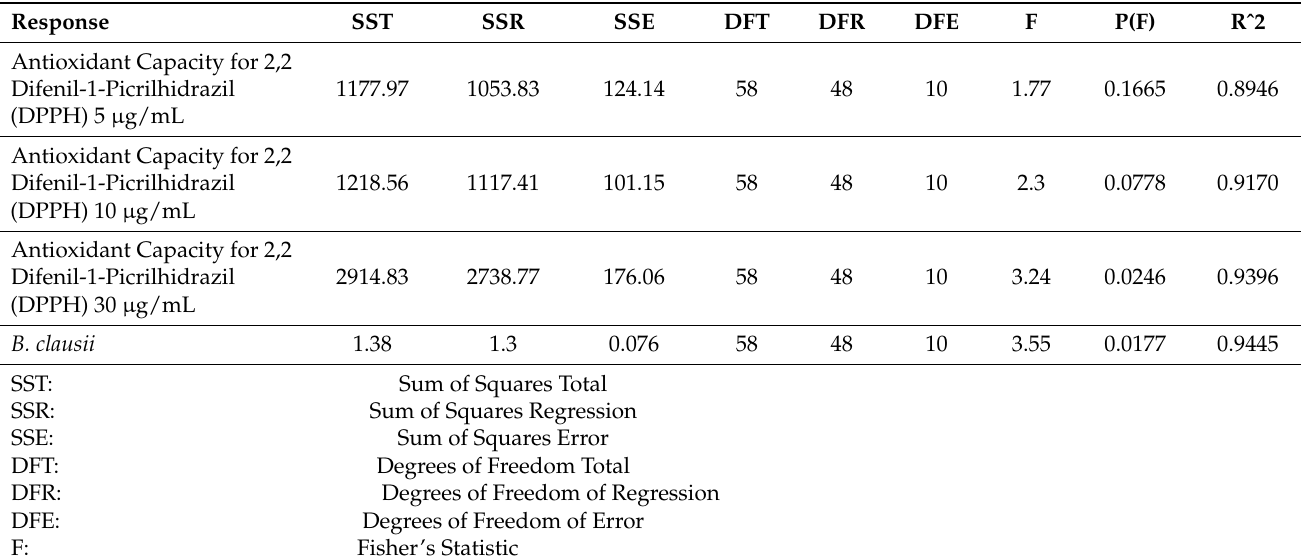
Table 2. Statistical ANOVA details for each response